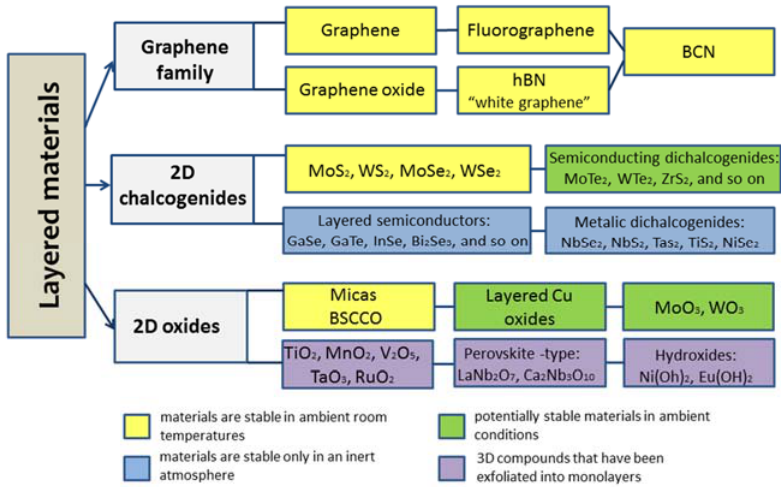
Figure 1. Chart illustrating the categorized library of 2D materials. Data are adapted from [16]. hBN is a hexagonal boron nitride; BCN is 2D nanocomposites containing boron, carbon and nitrogen; BSCCO is bismuth strontium calcium copper oxide.